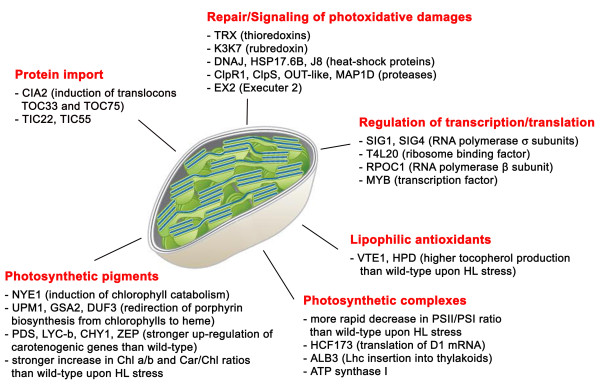
Transcriptional induction, dose-dependent to 1O2, of genes encoding chloroplast proteins. Most relevant genes encoding chloroplast proteins, that showed a statistically significant response to high light at low temperature only in npq1lut2, are reported. Up-regulation is defined as described in Methods. Abbreviations: ALB, albino; CIA, chloroplast import apparatus; CHY, carotene hyroxylase; DUF, uroporphyrinogen III synthase; GSA, glutamate-1-semialdehyde 2,1-aminomutase; HCF, high chlorophyll fluorescence; HPD, 4-hydroxyphenylpyruvate dioxygenase; LCY, lycopene cyclase; NYE, non-yellowing; PDS, phytoene desaturase; SIG, RNA polymerase sigma subunit; TIC/TOC, translocon of inner/outer chloroplastic membrane; UPM, urophorphyrin methylase; VTE, tocopherol cyclase; ZE, zeaxanthin epoxidase.